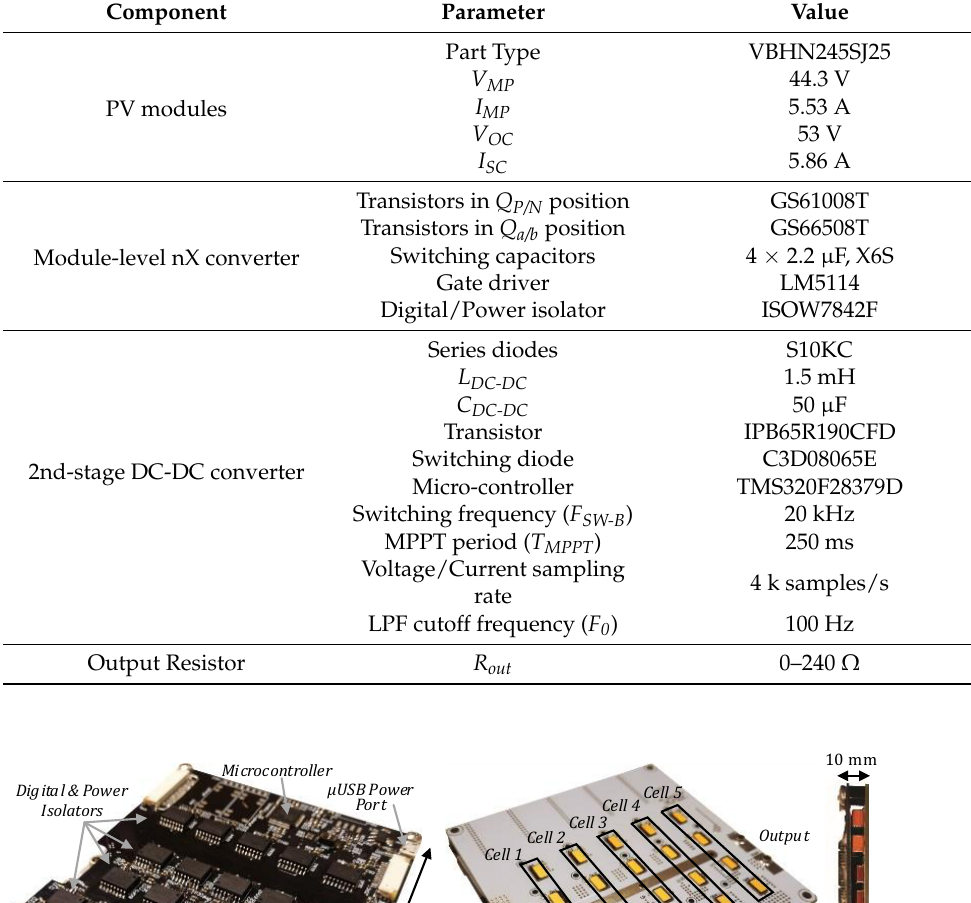
Table 1. List of components of the experimental setup.